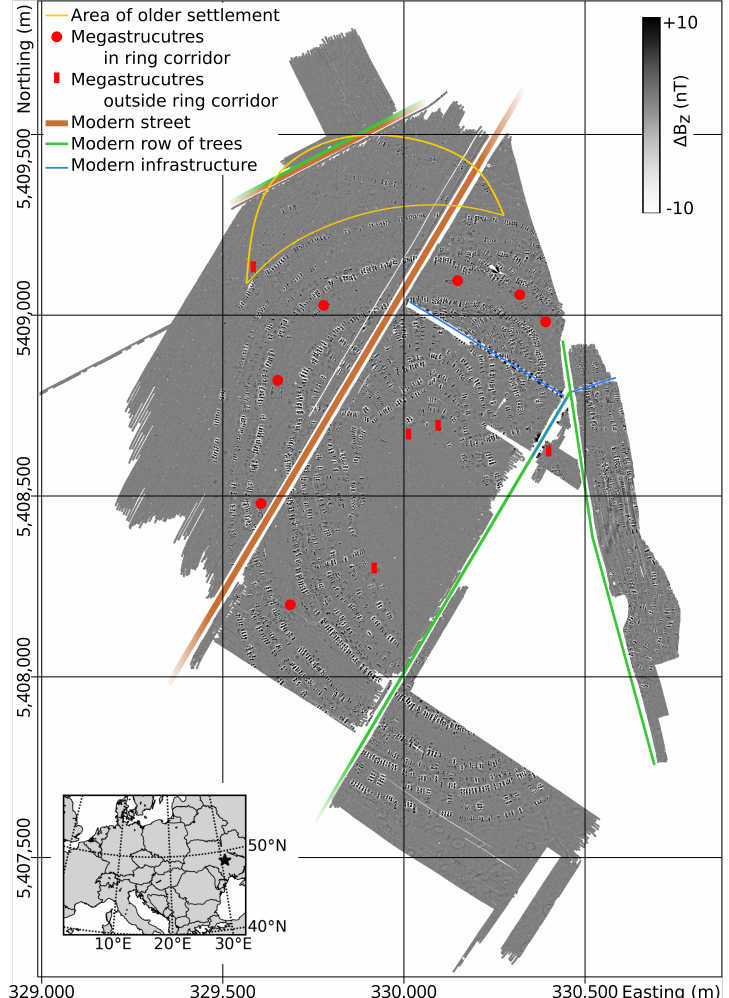
Figure 1. Magnetic map of the Maidanetske site (data kindly provided by the Romano-Germanic Commission, German Archaeological Institute, and Institute of Prehistoric and Protohistoric Archae- ology, Kiel University; projection: UTM 36N). The locations of megastructures inside the ring corridor are marked with red circles, the remaining ones with red blocks. Moreover, the area of the older settlement phase is outlined in yellow. The measured area is interrupted by a modern street (brown), infrastructure (blue), and rows of trees